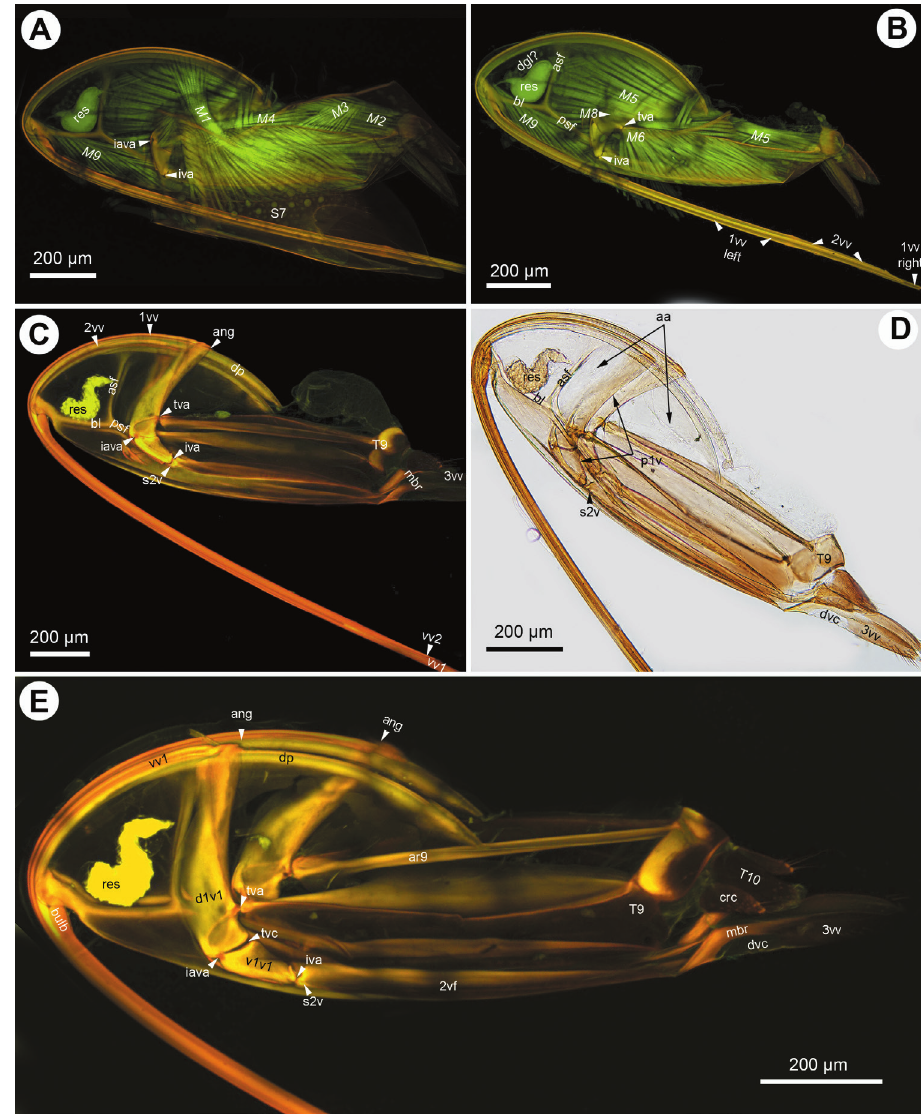
Figure 3. CLSM micrographs and bright field image showing the female terminalia of Trassedia luapi (Cancemi). A CLSM, lateral view, T8 intact (doi: 10.6084/m9.figshare.156440) B CLSM, lateral view, T8 removed (doi: 10.6084/m9.figshare.156438) C CLSM, lateral view, muscles removed (doi: 10.6084/ m9.figshare.156444) D bright field, lateral view, muscles removed e CLSM, lateral view, muscles re- moved (doi: 10.6084/m9.figshare.156467). All anterior to the (ch45:0; 3vv : Figs 1B, 2B–E, 3C–E, 4D, F, 5E, F, 6A, B, F), its lateral wall is convex (ch46:0) and sclerotized (ch47:0) whereas its medial wall is concave (ch48:0; 3vv : Fig. 3E) and membranous (ch49: 0; 3vv : Fig. 3F).